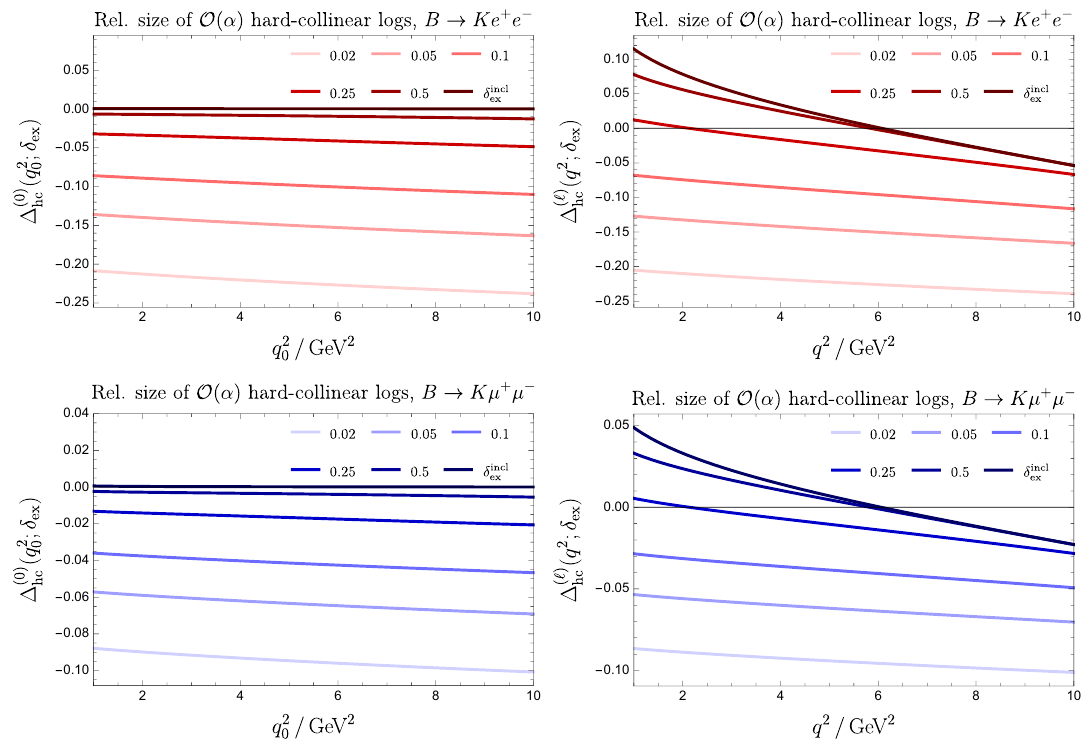
Figure 7 . Hard-collinear logs ∆ ( a ) ( q 2 ; δ ex ) as a function of q 2 for the electron and muon (top) a a hc and (bottom) respectively. The quantity is shown for various photon energy cut-offs δ ex (2.4). It is noted that for δ ex = δ inc , the cancellation of the logs can be seen, though not completely, as we ex only show a restricted interval of q 2 . Bottom and top figures are similar by a scaling factor cf. (A.2) and the explanation above